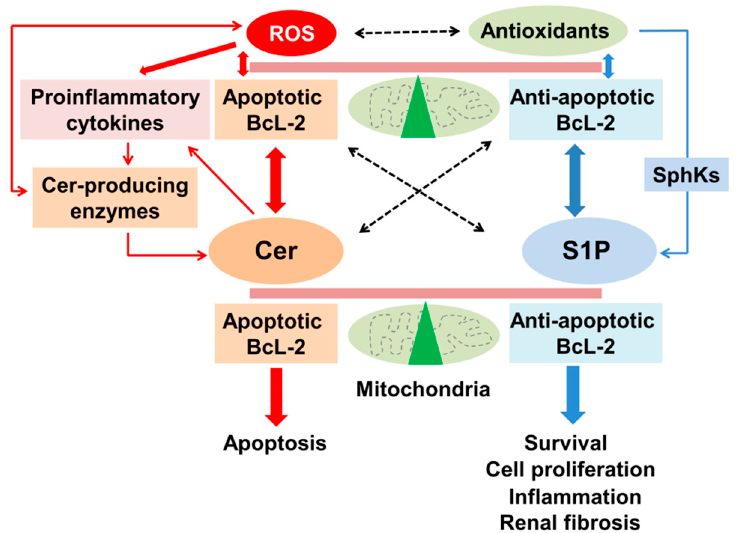
Figure 2. Balance between ROS and antioxidants determines ceramide-S1P rheostat that regulates oxidant-induced kidney injury. A rheostat of ROS and antioxidants regulates enzymes that generate Cer and S1P directly or through the modulation of subcellular translocation of the enzymes and upstream signaling pathways, mitochondrial function including apoptotic/anti-apoptotic Bcl-2 family proteins, and proinflammatory cytokines. ROS activate Cer-producing enzymes and vice versa, while antioxidants inhibit these enzymes. ROS stimulate proinflammatory cytokines, which in turn induce Cer generation, mitochondrial dysfunction, upregulation of apoptotic and downregulation of anti-apoptotic Bcl-2 proteins, leading to apoptosis, while antioxidants have the opposite effect. Cer induces ROS production, mitochondrial dysfunction and increased ratio of apoptotic/anti-apoptotic Bcl-2 proteins and inhibition of antioxidants, leading to apoptosis. ROS inhibit SphK/S1P and vice versa, while antioxidants activate it. SphK/S1P has the opposite biological effects to Cer, including restoration of mitochondrial function and the ratio of apoptotic/anti-apoptotic Bcl-2 family proteins, thereby promoting survival, cell proliferation, inflammation and renal fibrosis. → : stimulation, dashed arrow: inhibition. Red arrow; apoptotic, blue arrow; anti-apoptotic.